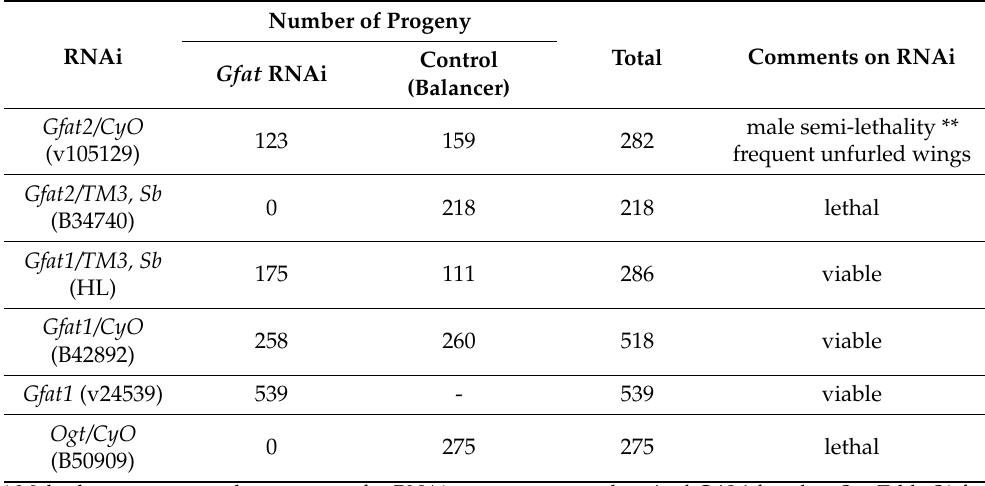
Table 3. Tests for viability effects of Gfat2 , Gfat1 , and Ogt RNAi knockdown in the larval nervous system at 29 ◦ C using Appl-GAL4 *.